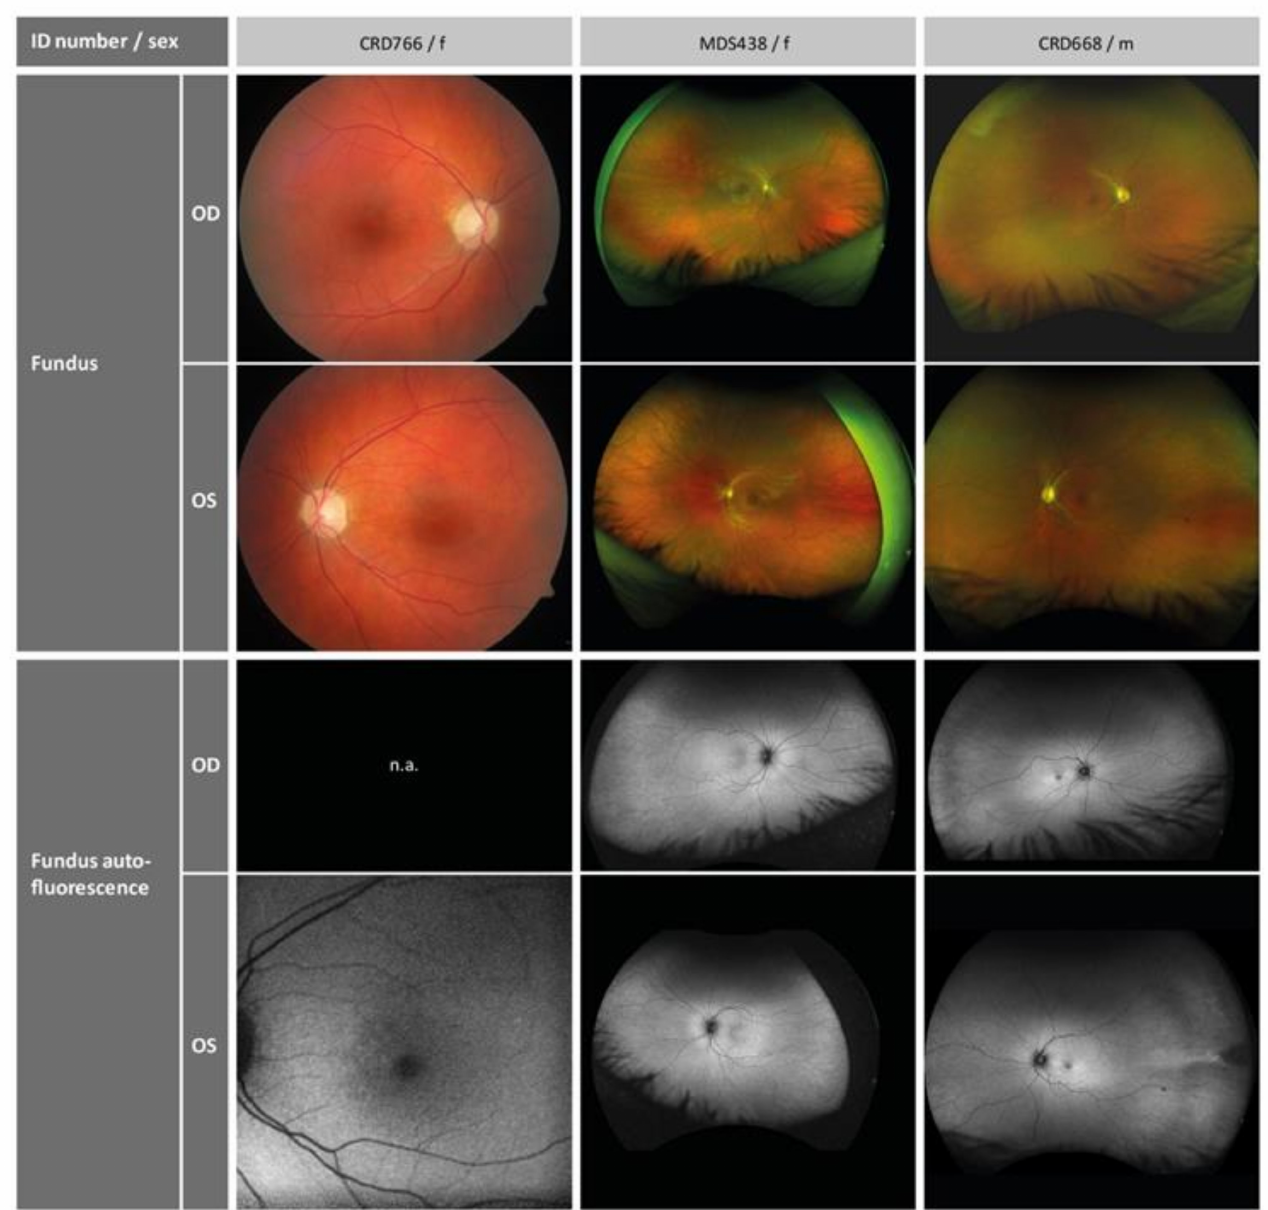
Figure 2. Retinal imaging of the three patients. OD, right eye; OS, left eye; f, female; m, male; n.a., not